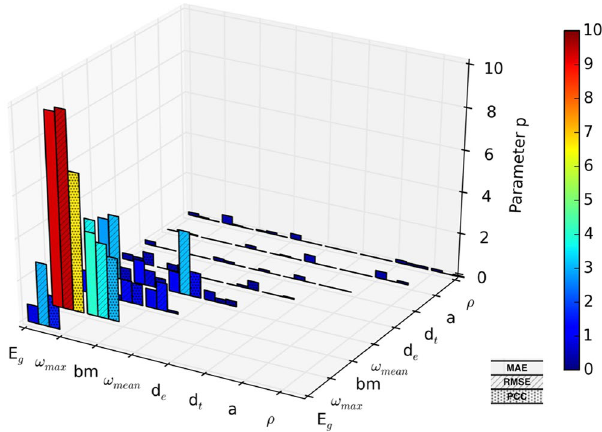
Figure 2. Distribution of the frequency of occurrence (parameter p) of products of two features.